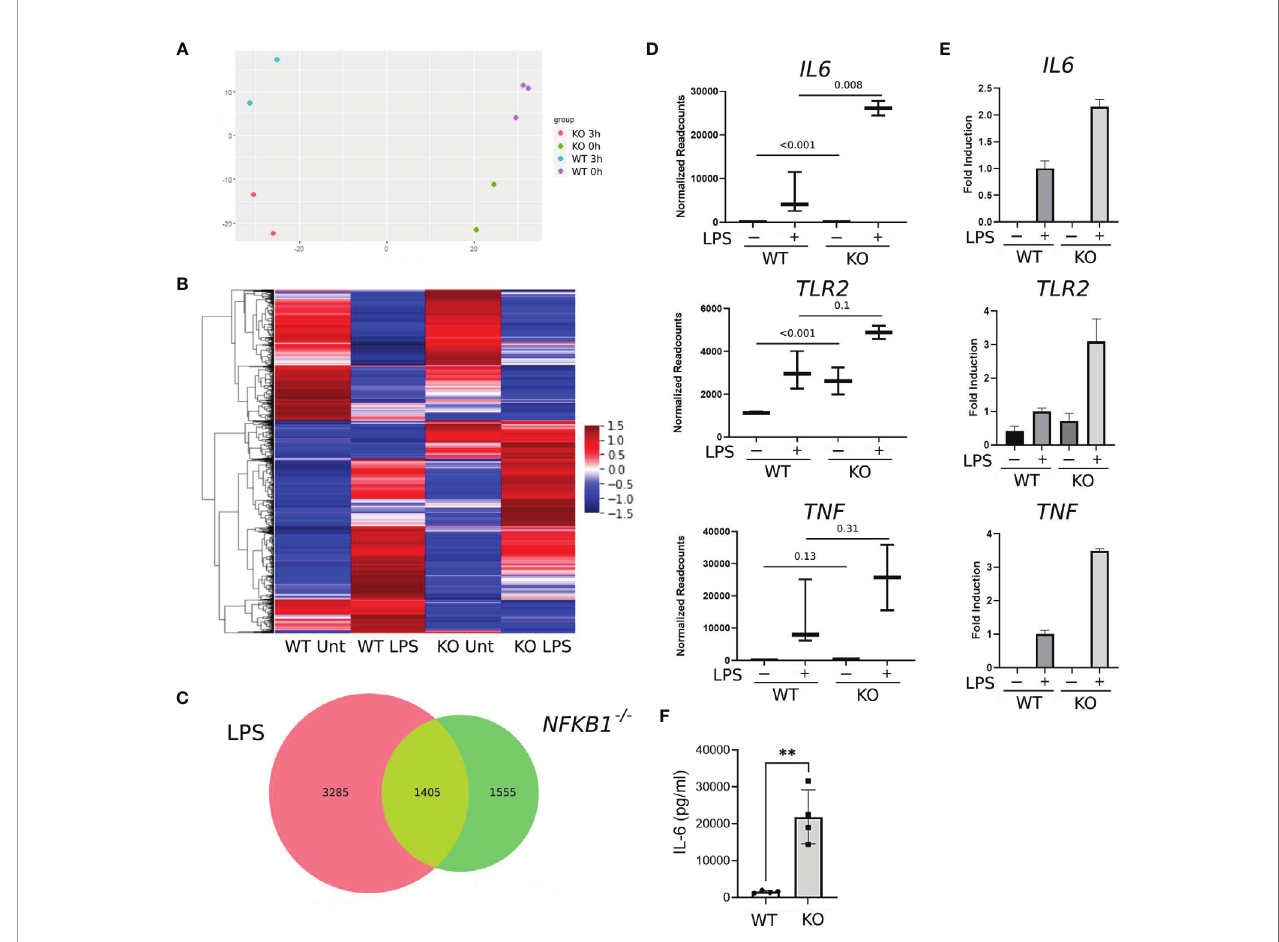
FIGURE 2 | NFKB1 deletion alters the transcriptional pro fi le of THP1 macrophages. (A) Principal component analysis plot showing sample similarity of RNAseq analysis of control (WT) and NFKB1 -/- (KO) cells untreated (Unt) or treated with LPS. (B) Heatmap showing differentially expressed genes, Z-score normalized. Relative expression is shown as the average of replicates ranging from maximum to minimum values. (C) Venn diagram showing the overlap of LPS-inducible genes and genes differentially expressed in NFKB1 -/- cells relative to WT cells in unstimulated and LPS stimulated conditions (p-value and q-value < 0.05). (D) Selected gene expression data plotted as normalized RNAseq readcounts. Data presented as mean ± SD of biological replicates, p values adjusted for Benjamini-Hochberg are indicated. (E) Patterns of expression for selected genes con fi rmed in an independent experiment using QPCR. Data presented as mean ± SEM of technical replicates. (F) PMA-induced macrophages from WT and NFKB1-/- THP1 cells were stimulated with LPS, and the supernatant was analysed by IL-6 ELISA. (n = 4, data presented as mean ± SD of four independent experiments). **p < 0.003 using T-test